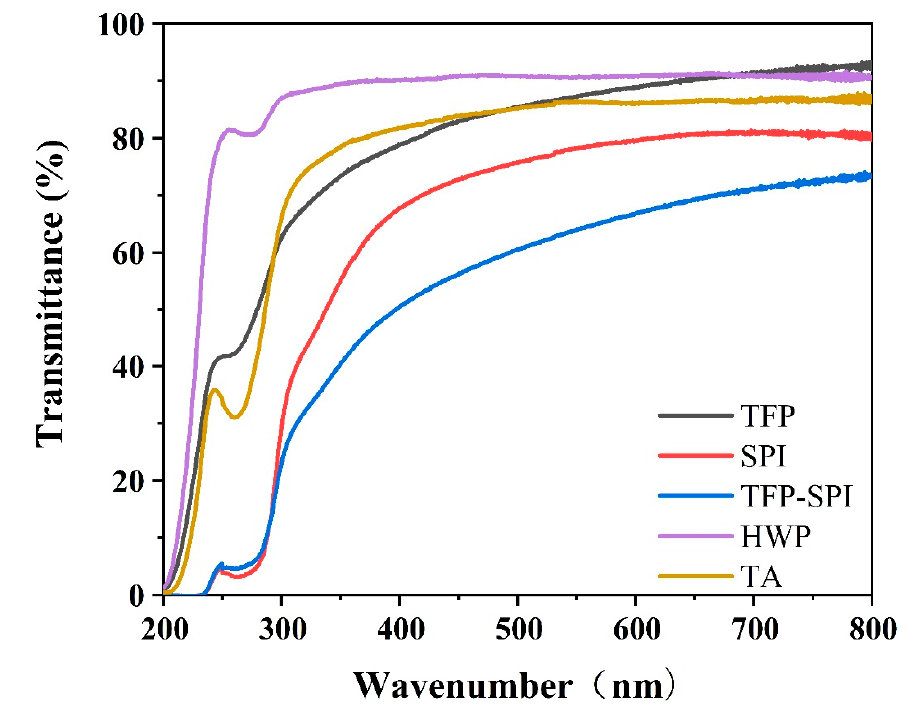
Figure 8. Ultraviolet spectroscopic spectra of different substances.